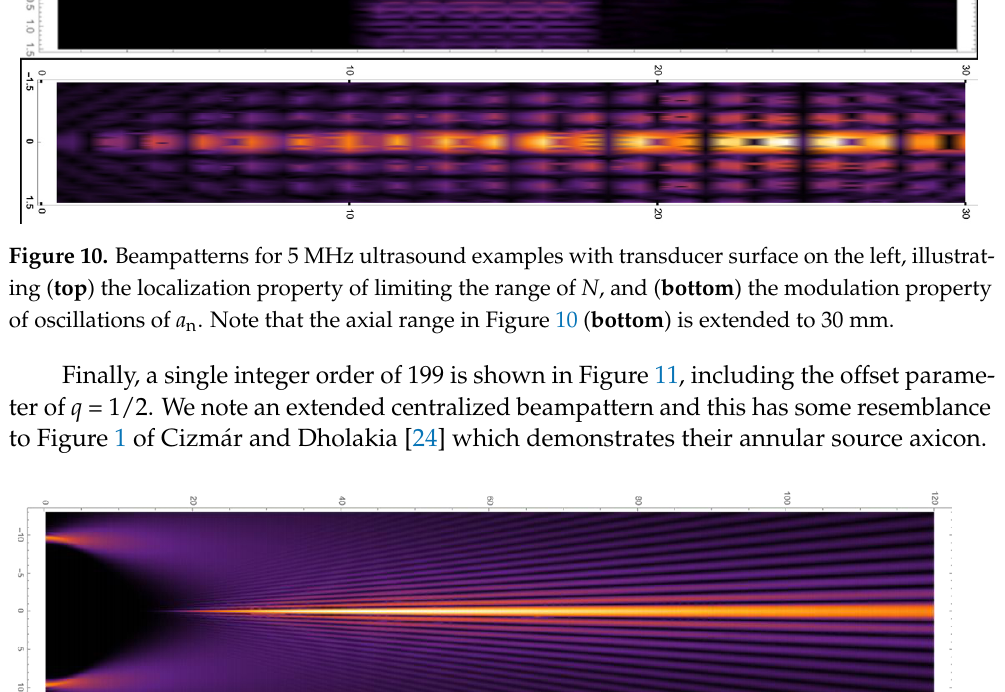
Figure 9. Beampatterns with the same parameters as Figure 6 (top) with the addition of the z offset by imaginary number q = 1/2 (top) and 1 (bottom). The q factor produces stronger source amplitudes at radii greater than 9 mm (beyond the scale shown), which contribute to the emerging pattern at axial range greater than 10 mm.